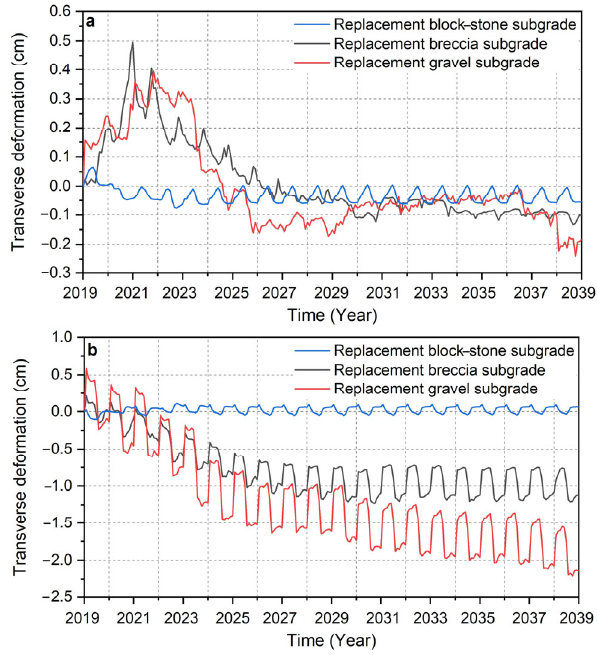
Figure 21. Actual transverse deformation curves at the road centerline and the shoulder of the three subgrade structures: ( a ) at the road centerline and ( b ) at the shoulder.